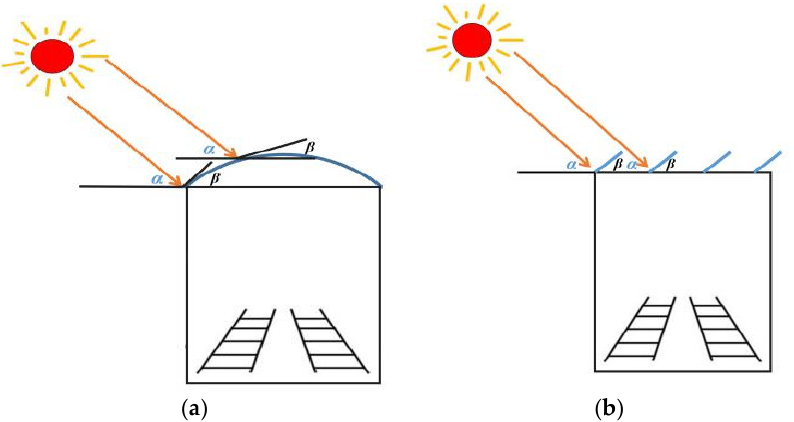
Figure 3. Equivalent figure of PV arrangement for different railway directions: ( a ) north–south railway arrangement; ( b ) east–west railway arrangement.